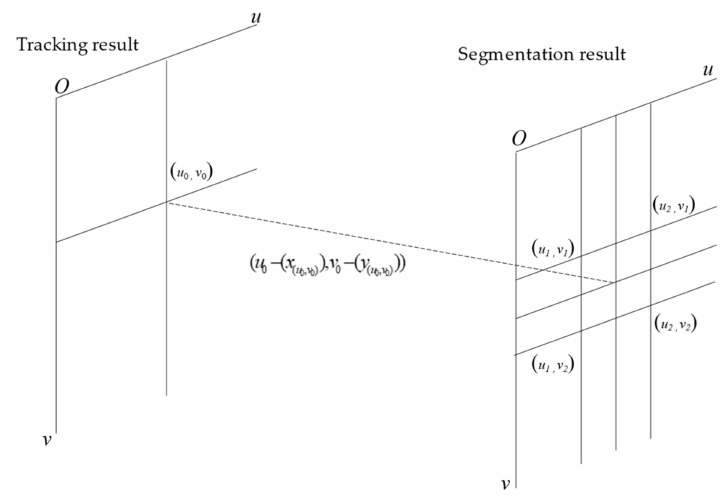
Figure 6. Operation schematic diagram of wrapping unit.